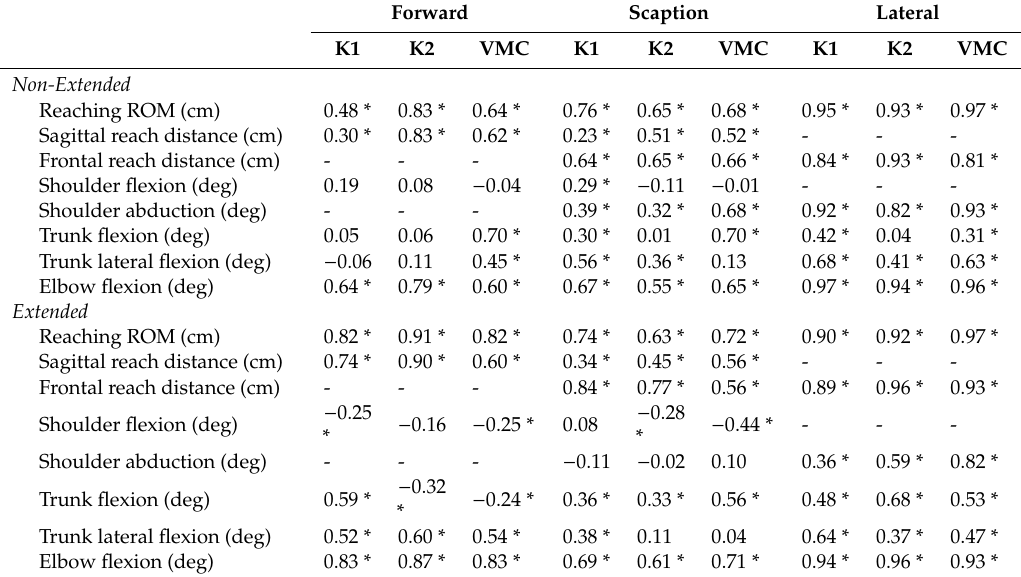
Table A3. Reliability measured by Pearson’s correlation coe ffi cients (r) between testing days D1 and D2 for each of the three